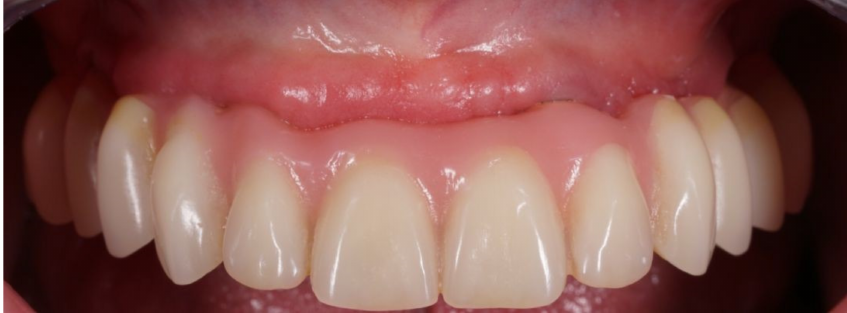
Figure 6. Definitive prosthesis with cantilevers after 7 years of use.